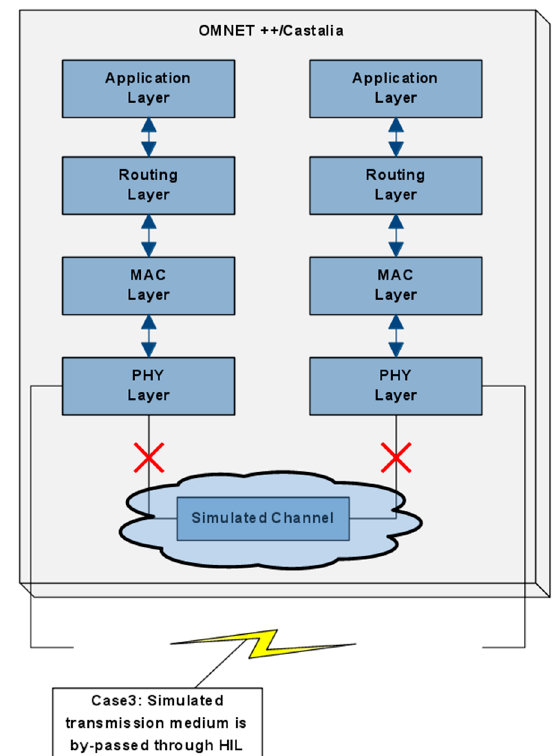
Figure 16. Wireless Medium HiL Scenario.